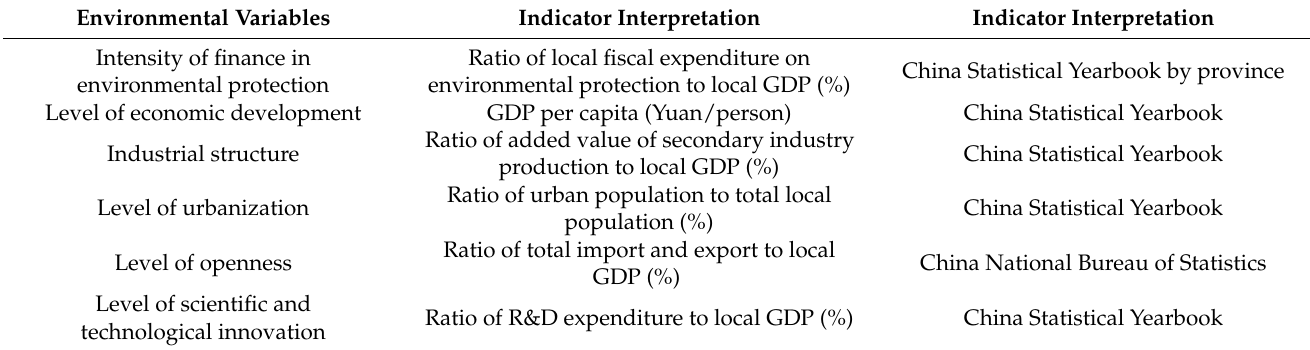
Table 2. Composition of external driver